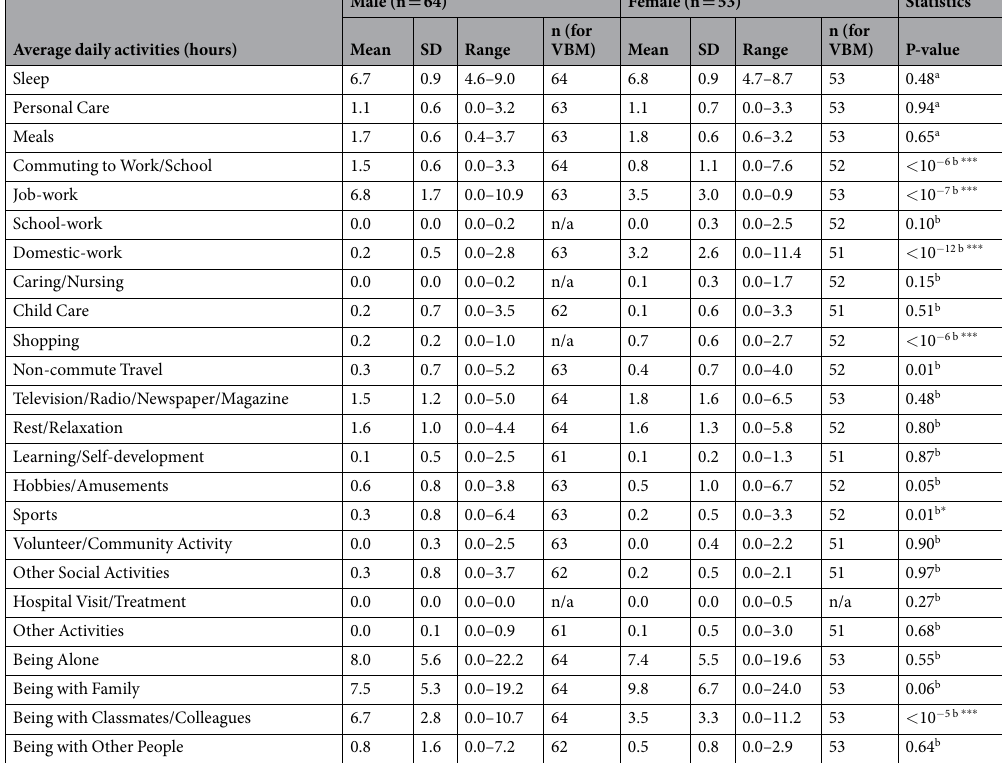
Table 2. Average daily activity. * p < 0.05, ** p < 0.01, *** p < 0.001, a t-test, b Mann-Whitney U test, n/a: not